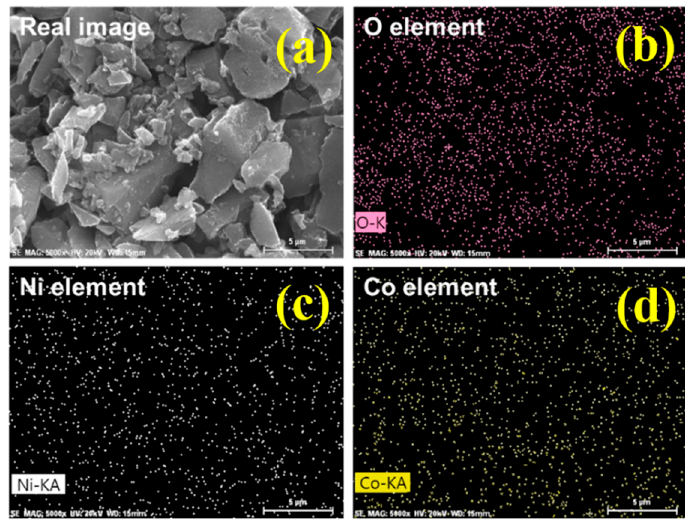
Figure 2. The FE-SEM real image of NCOCC-55 ( a ) and the oxygen ( b ), Ni ( c ) and Co ( d ) mapped by EDS analysis.